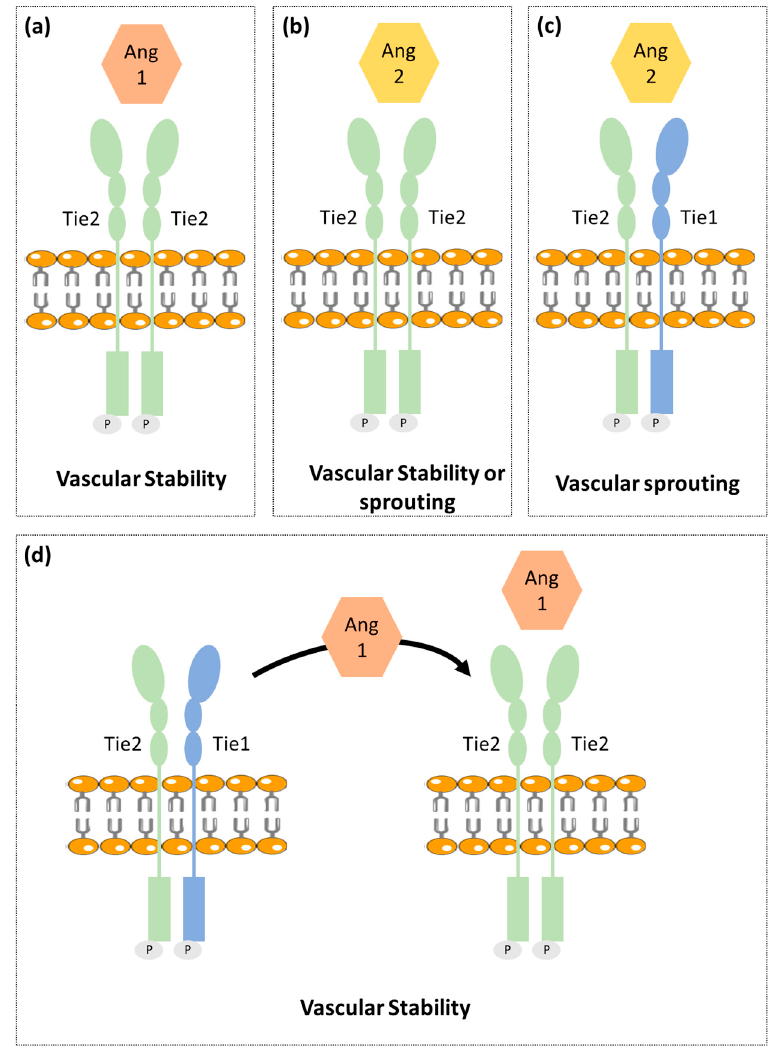
Figure 1. Schematic illustration of the vessel stability regulation by Ang/Tie signaling. ( a ) Ang1 binds to Tie2 promoting vascular stability. ( b ) Ang2 has a dual function acting as a Tie2 agonist or antagonist to promote vascular stability or sprouting, respectively. ( c ) Tie1 forms a complex with Tie2. Upon Ang2 stimulation, Tie1 and Tie2 remain associated and Ang2 induces vascular sprouting. ( d ) Ang1 stimulation promotes Tie2 clustering leading to vascular stability. This schematic representation includes the most consensual theories; however, this pathway is not yet fully understood. Besides that, this figure is a schematic representation that is not intended to translate the real chemical conformation of the proteins.